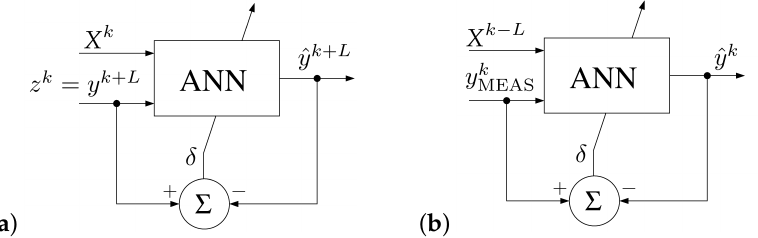
Figure 2. BP learning algorithm in brief: ( a ) a conventional approach, ( b ) proposed